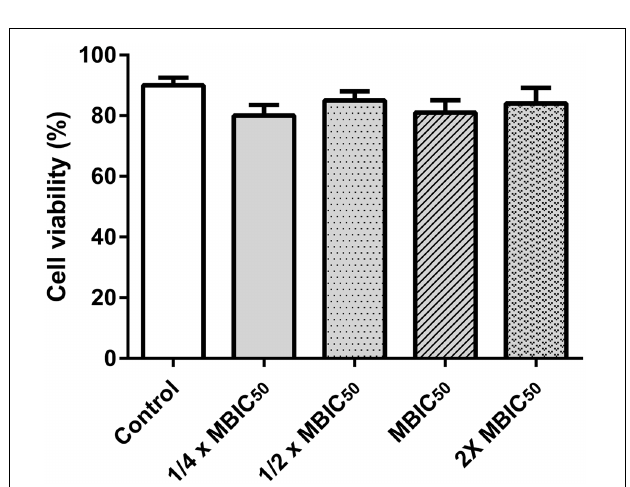
FIGURE 3 | Effect of ADM 3 on protease production in S. aureus (ATCC 25923—reference strain; QSL2040—clinical isolate). The concentrations used were 1 / 4 × MBIC 50 (1.25 µ g/mL), 1 / 2 × MBIC 50 (2.5 µ g/mL), MBIC 50 (5 µ g/mL), and 2 × MBIC 50 (10 µ g/mL).